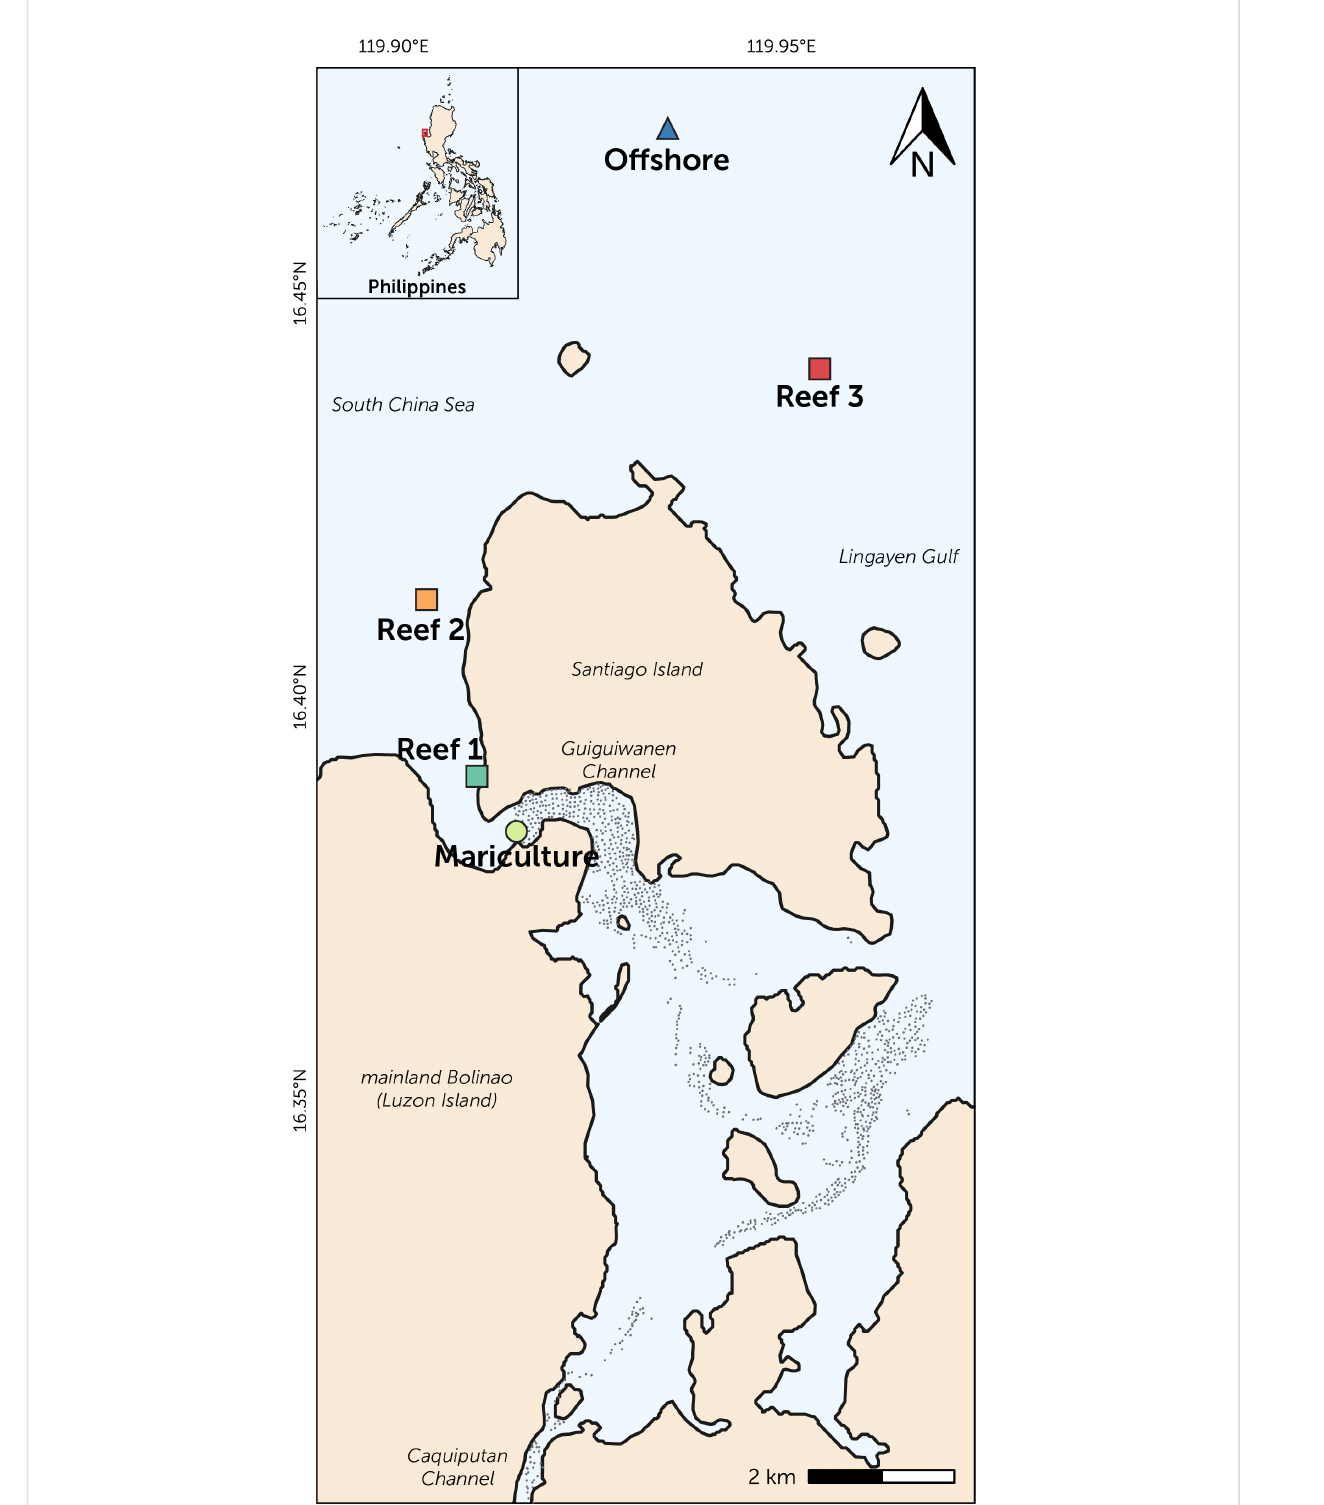
FIGURE 1 Map of Bolinao, Pangasinan showing the sampling locations: mariculture station (circle), three reefs (squares), and offshore station (triangle). Approximate location of mariculture structures (black dots) is also